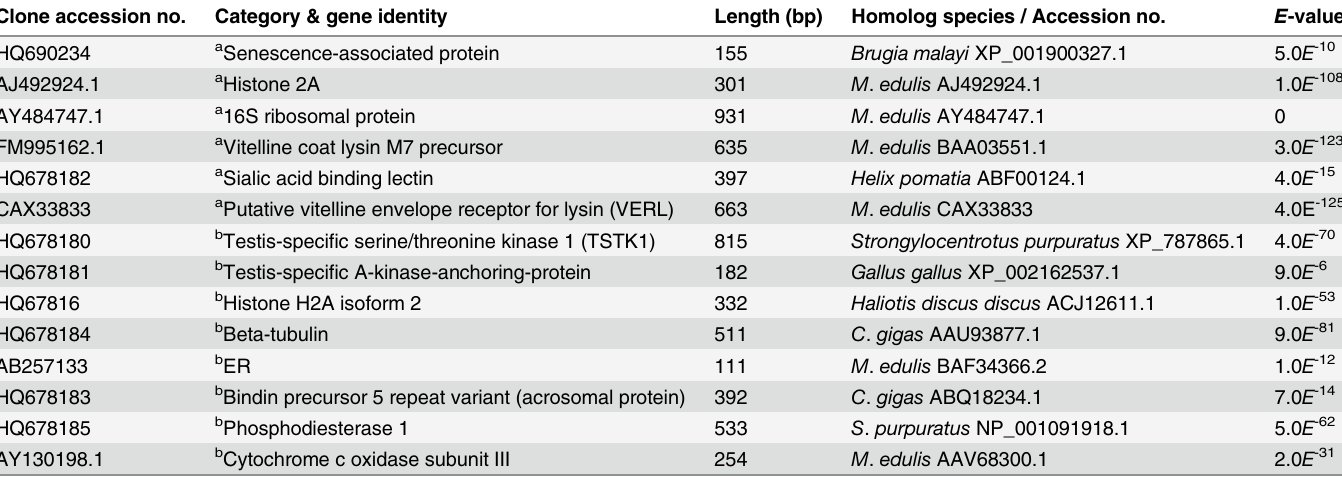
Table 1. Differentially expressed (subtracted) mRNAs identified in M . edulis testis at two stages of gonadal development. a Down-regulated in early developing testes relative to mature testes. b Up-regulated in early developing testes relative to mature testes. Clone accession no.